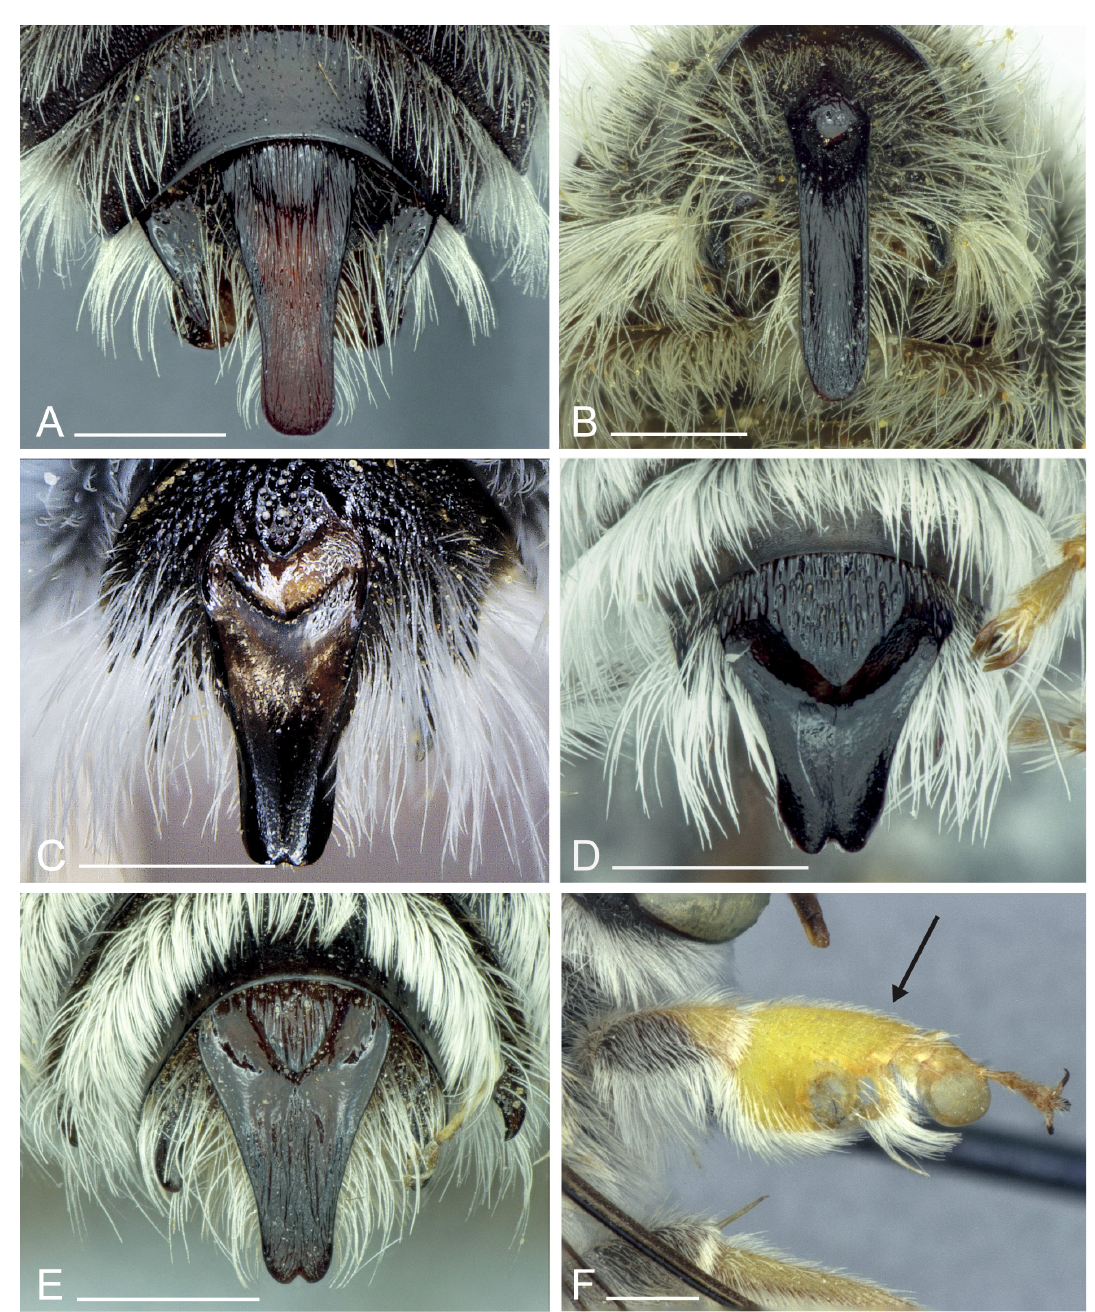
Fig. 6. Fidelia spp., ♂♂. A – E . T7. A . Fidelia friesei (Brauns, 1926). B . F. pallidula (Cockerell, 1935). C . F. hessei Whitehead & Eardley, 2003. D . F. whiteheadi Litman & Kuhlmann sp. nov. E . F. fasciata Whitehead & Eardley, 2003 (paratype). F . F. fasciata , forebasitarsus (paratype). Scale bars: 1